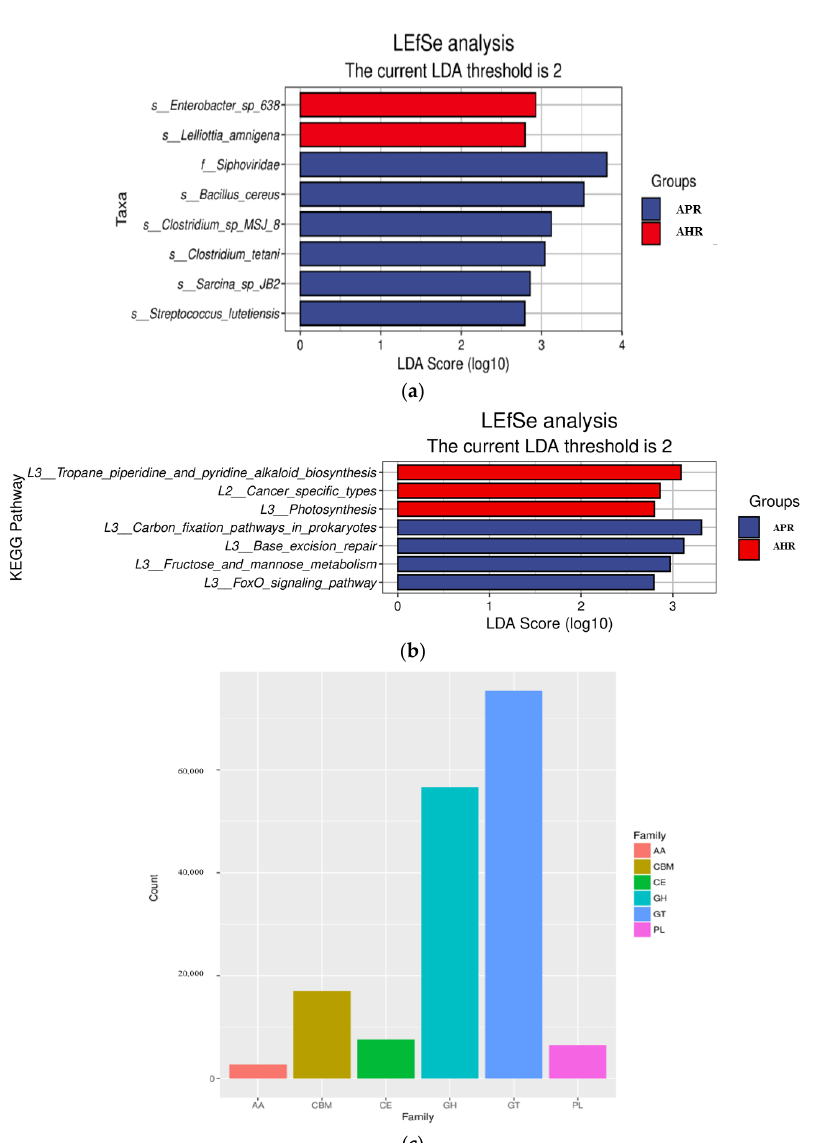
Figure 3. Column chart of LEfSe analysis of gut microbes of captive giant pandas. ( a ) Column chart of LEfSe analysis of gut microbes of captive giant pandas. ( b ) LEfSe functional histogram. Notes: In the figure, the ordinate is the taxa with significant differences between groups, and the abscissa is a bar chart to visually display the LDA analysis logarithmic score value of each taxon. The taxa are ordered by the size of the score value to describe their specificity in the sample grouping. The longer the length, the more significant the difference of the taxon is, and the color of the bar chart indicates the most abundant sample grouping corresponding to the taxon. ( c ) Statistical chart of EggNOG functional group annotation results. Notes: In the figure, the abscissa corresponds to each CAZy enzyme functional module, and the ordinate is the number of protein families annotated to the corresponding